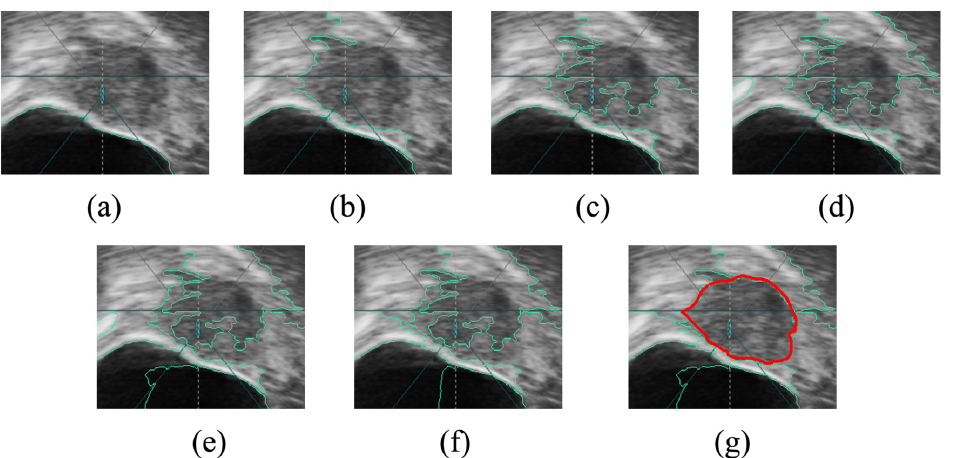
Fig 8. Results with different F values. (a) F = 2. (b) F = 3. (c) F = 4. (d) F = 5. (e) F = 6. (f) F = 7. (g) F = 8. When F = 8, the tumor is segmented. The tumor boundary is depicted with a red